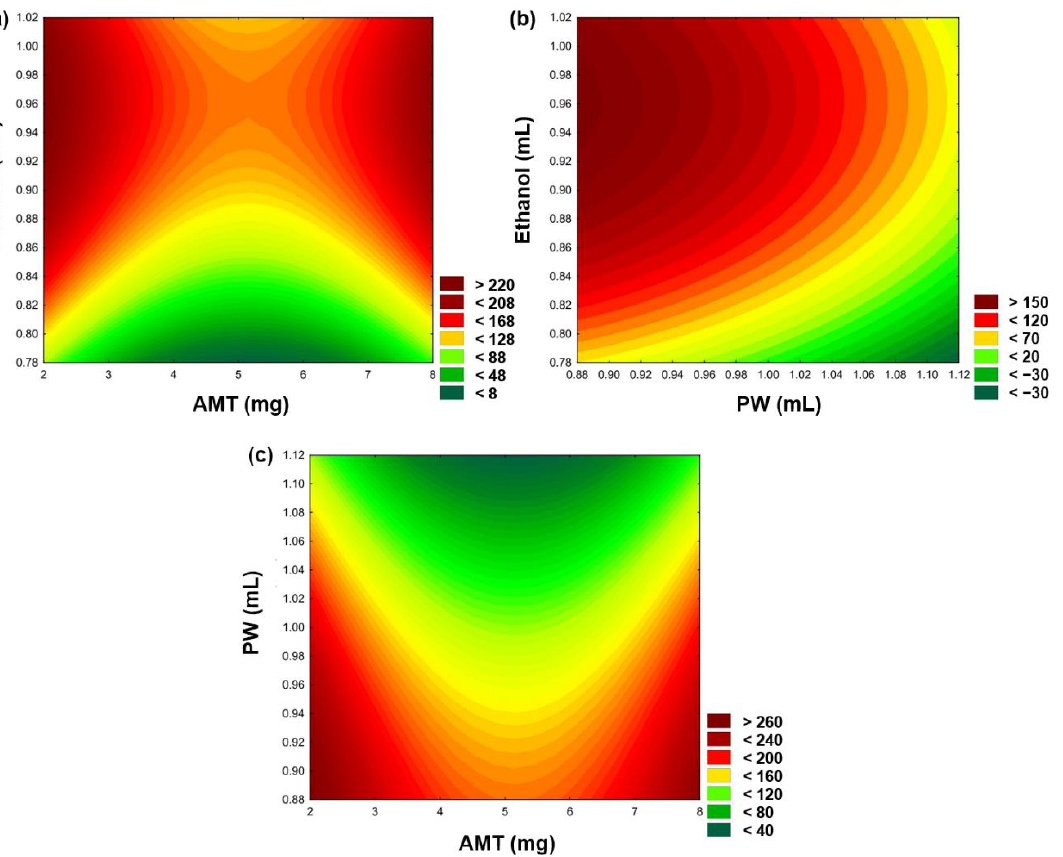
Figure 1. Response surface plots showing the effect of independent variables: AMT–ethanol ( a ), PW–ethanol ( b ), and AMT–PW ( c ) on Z-average.